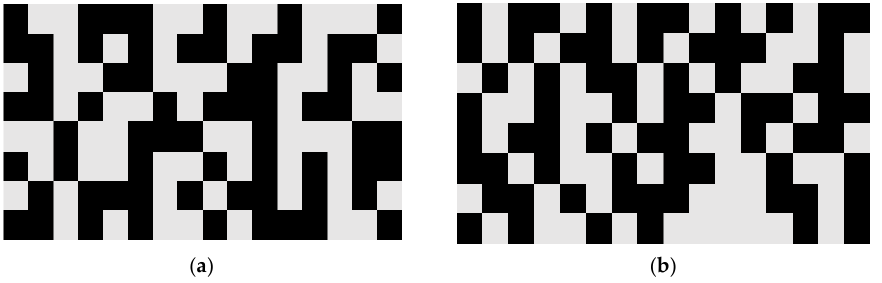
Figure 4. ( a ) Process on encryption with 128 bits, ( b ) process of decryption with 128 bits.